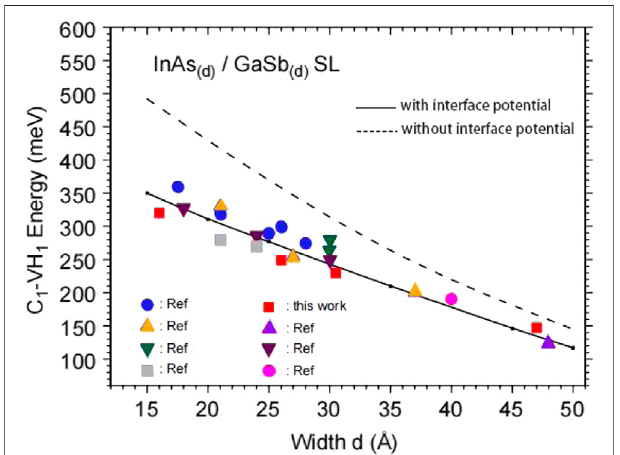
FIGURE 5 | Evolution of the C 1 – VH 1 fundamental interminiband transitionenergyoftheInAs(m)/GaSb(m)SLstructurewiththelayerthickness: theoreticalcalculationsconductedwith(solidline)andwithout(dashedline)an additional interface potential; experimental data extracted from PL measurements in this work (solid square) and from other works.